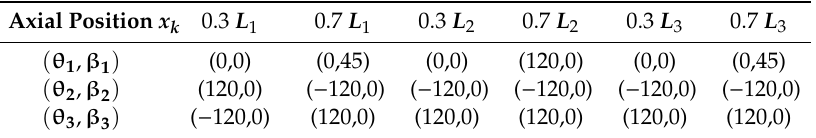
Table 1. Strain sensor locations.